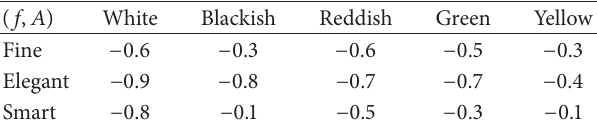
Table 7: Tabular representation of (𝑓,𝐴) .